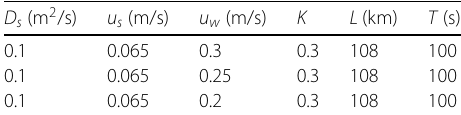
Table 5 Convergence of FTCS method and Saulyev method for some grid spacing T (cid:4) x (cid:4) t FTCS Saulyev 100 0.10 0.04 Stable Stable 0.05 Stable Stable 0.06 Untable Stable 0.07 Untable Stable 100 0.05 0.04 Untable Stable 0.05 Untable Stable 0.06 Untable Stable 0.07 Untable Stable 100 0.025 0.04 Untable Stable 0.05 Untable Stable 0.06 Untable Stable 0.07 Untable